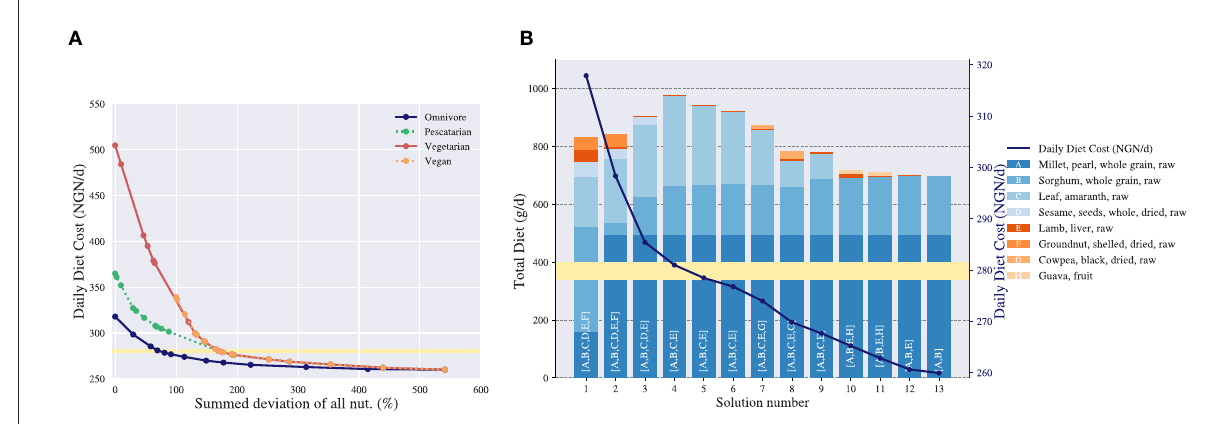
FIGURE4 Trade-off analysis of the daily diet cost in Nigerian naira (NGN/d) vs. the nutritional deviation measured as summed deviation for an adolescent female of 16–17 years. in Ebonyi. (A) Pareto curve of the daily diet cost vs. the nutritional deviation. Four diet types are considered: omnivore, pescatarian, vegetarian and vegan. Each dot is an efficient solution representing a trade-off between cost and nutritional adequacy. The yellow highlighted area indicates a price level around 280 NGN. (B) Daily diet composition corresponding to the trade-offs of cost vs. nutritional deviation for the omnivore diet. The left y -axis shows the total amount of a food commodity included in a particular diet in grams and the right y -axis shows the cost of the diet that corresponds to the y -axis of (A) . The solutions in (B) correspond to the solutions of the omnivore diet in (A) . The food commodities included in a particular diet are indicated with letters on the corresponding bar, where the length of the bar indicates the total daily grams of a food commodity included in the diet. The yellow highlighted area indicates a price level around 280